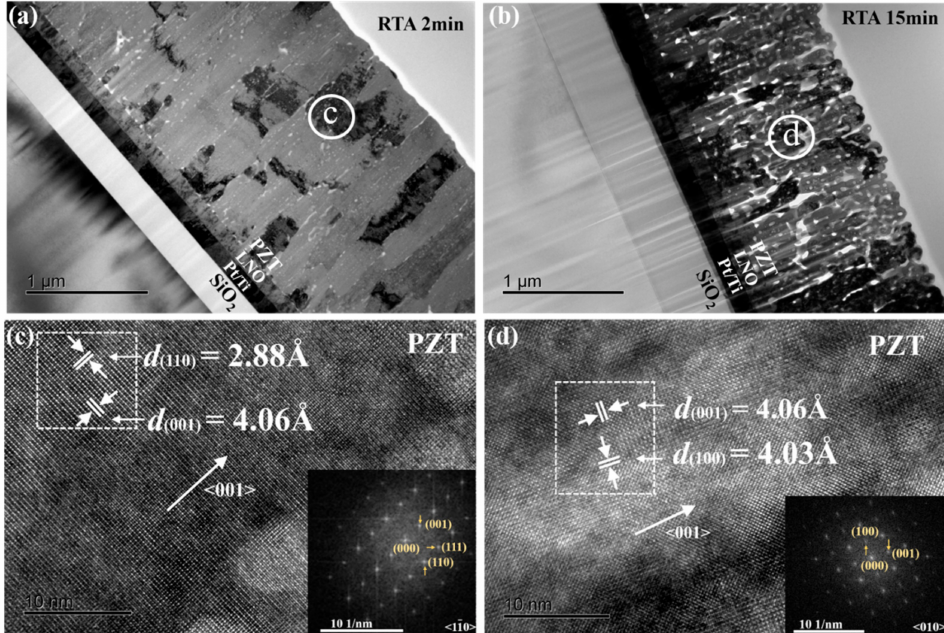
Figure 4. Cross-sectional TEM images of PZT films annealed for ( a ) 2 min and ( b ) 15 min. ( c , d ) High- resolution TEM images taken from ( a , b ), respectively, insets are selected area electron diffraction patterns (taken from the dashed rectangles) via Fast Fourier Transformation